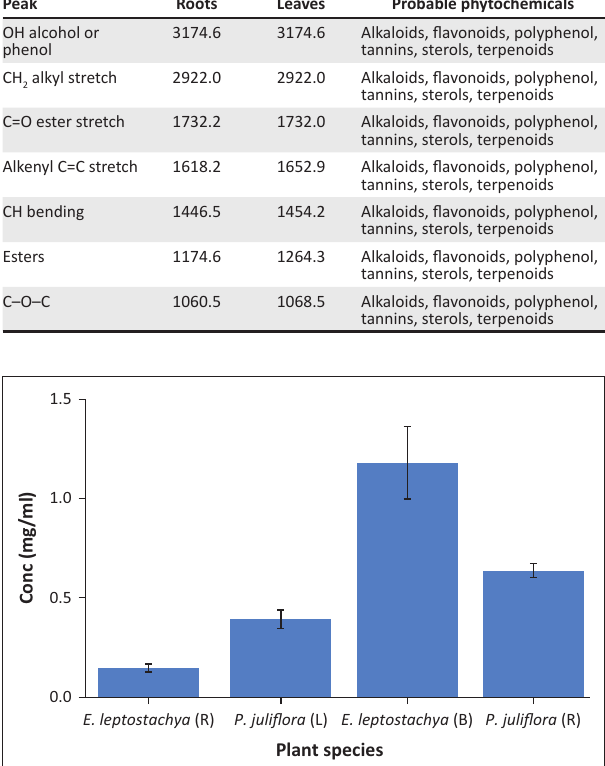
TABLE 1: Major bands observed in the Fourier transform infrared spectra of Entada leptostachya . Peak